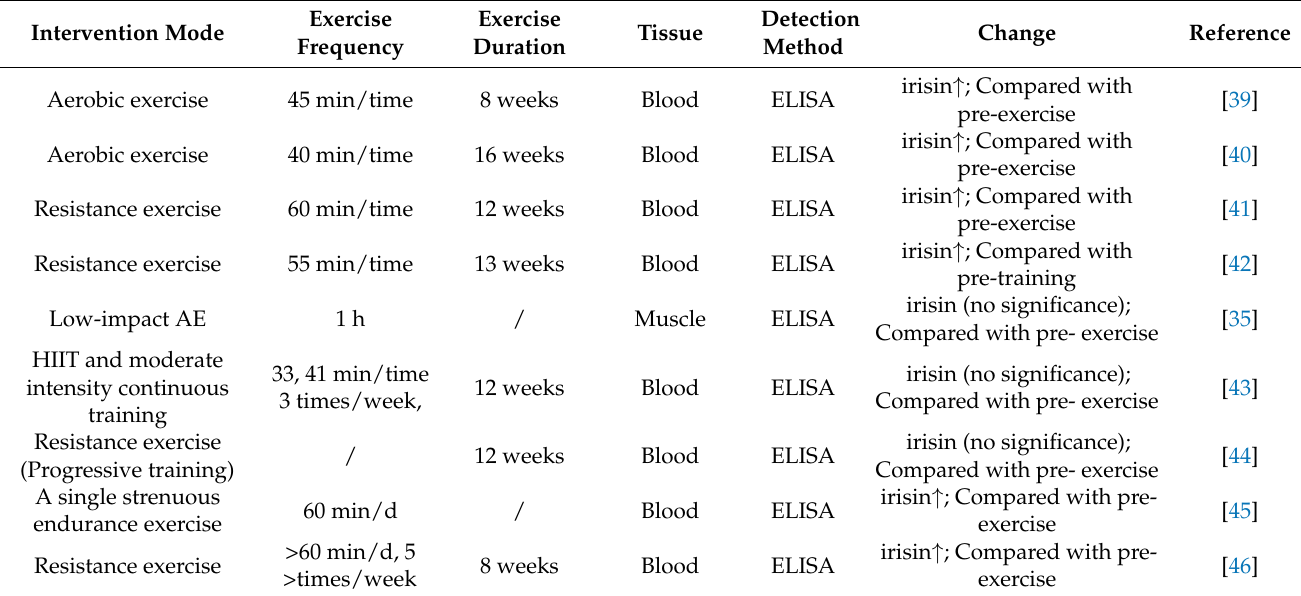
Table 1. The effects of different exercise modes on the irisin levels in